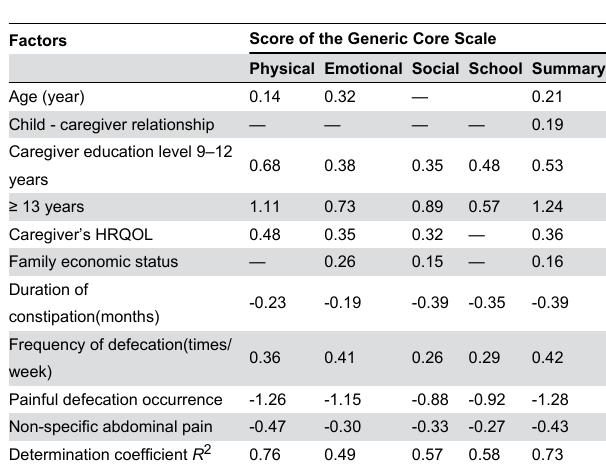
Table 4. The relationship between scores of the Generic Core Scale and FIM Scale.